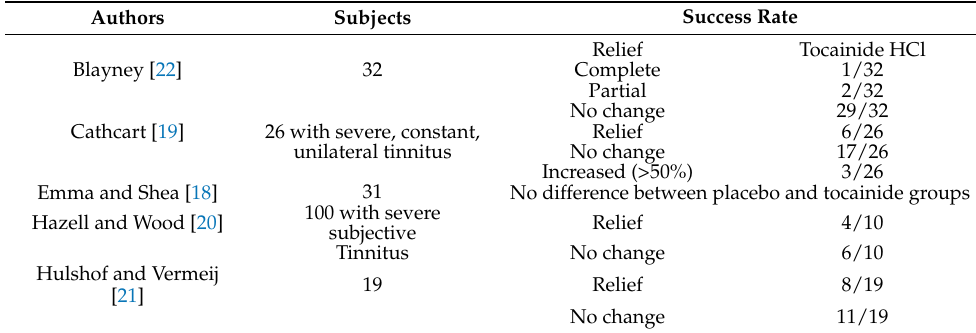
Table 3. Summary of studies that used tocainide HCl to treat tinnitus.